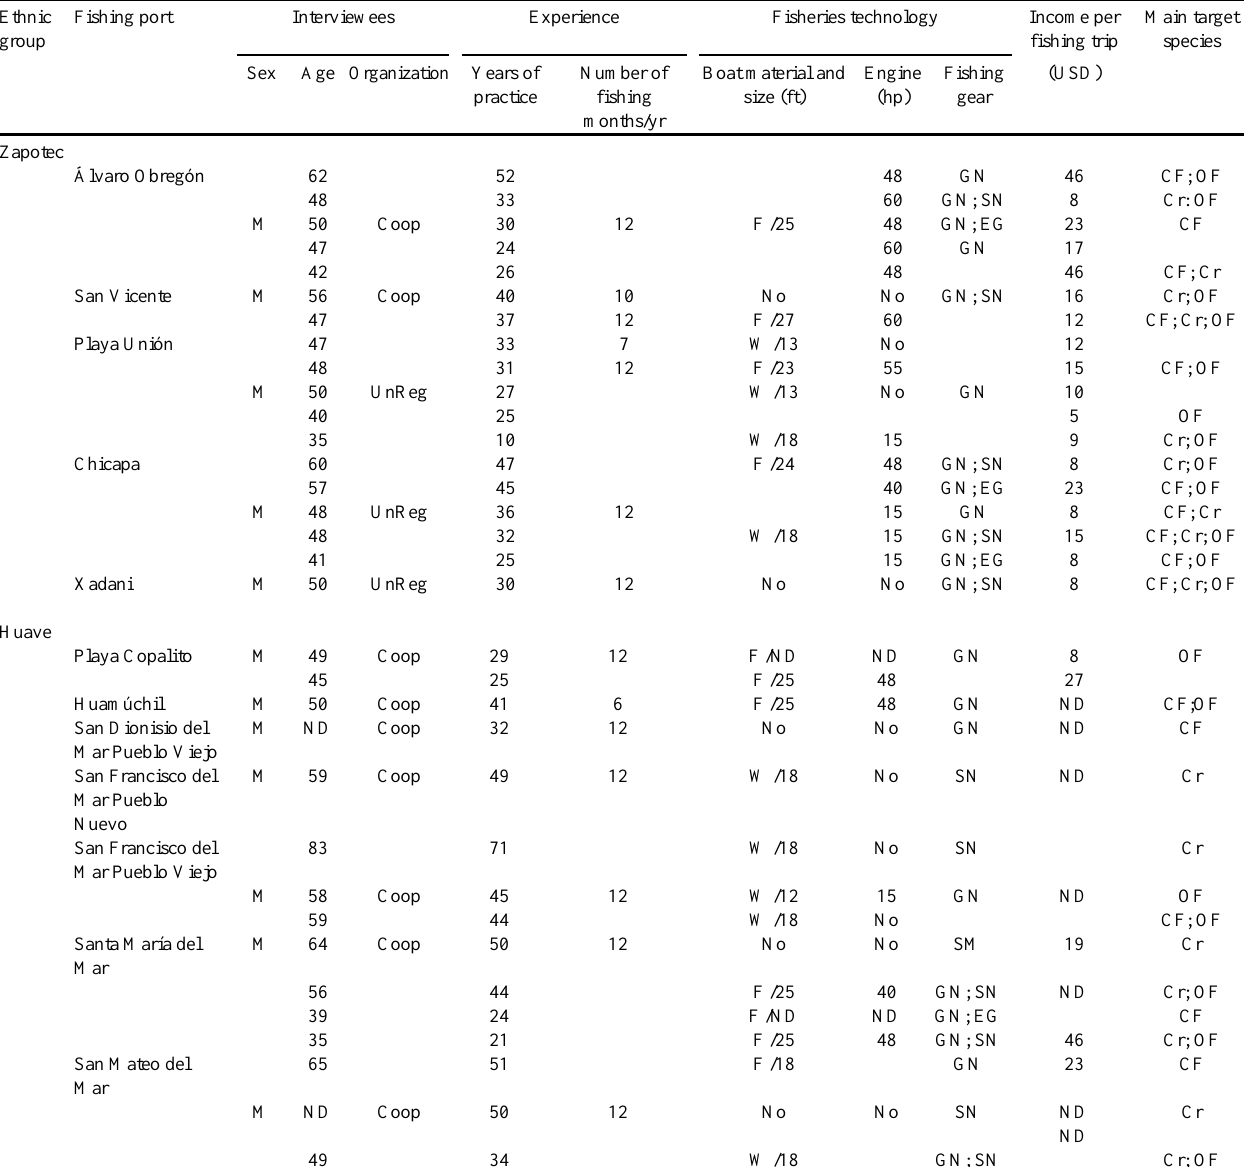
Table 1 . Research strategy (structured interviews with fishermen) to collect the traditional ecological knowledge from Zapotec and Huave ethnics in the Huave Lagoon System,